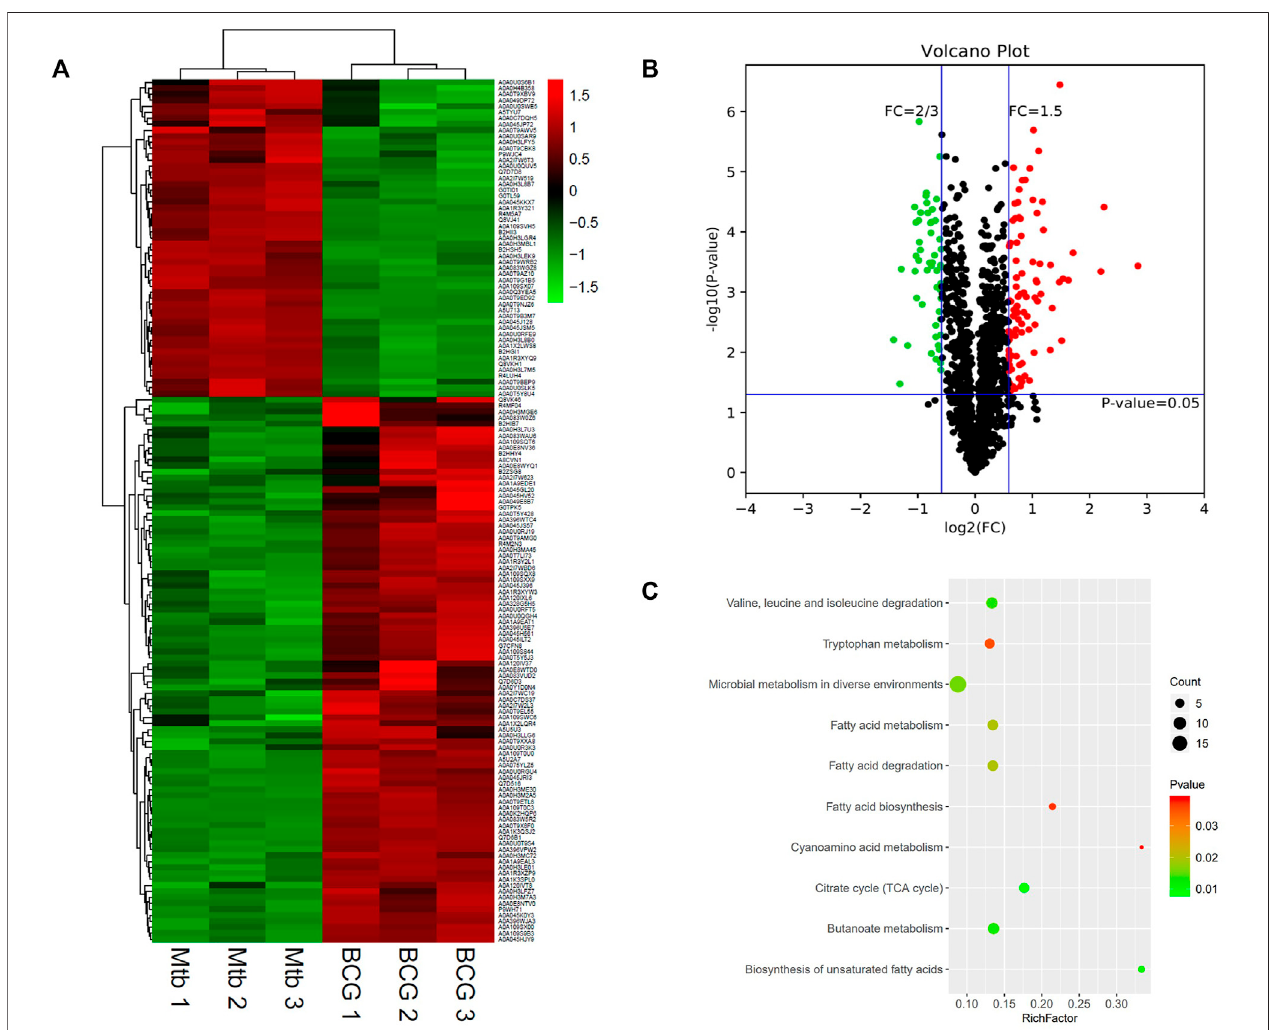
FIGURE5| Differentialprotein pro fi lebetween M.tb and BCG. (A) Heatmap ofproteins differentiallyexpressed betweenthegroupof M.tb andBCG.Green-to-red scale indicates low-to-high proteinsexpression levels( p < 0.05). (B) Volcanoplotsofproteins differentially expressed betweenthegroupof M.tb and BCG.Thered dots on the right indicate the signi fi cantly upregulated proteins, whereas the downregulated proteins are shown with green dots on the left. Differentially expressed proteins were de fi ned based on a threshold fold change > 1.5, at p < 0.05. (C) The top 10 KEGG pathways enriched for the signi fi cantly differentially expressed proteins. Entries with larger bubbles contain more differential genes. The color of the bubbles indicates the p value. The smaller the enrichment p value means the greater the degree of signi fi cance ( p < 0.05).